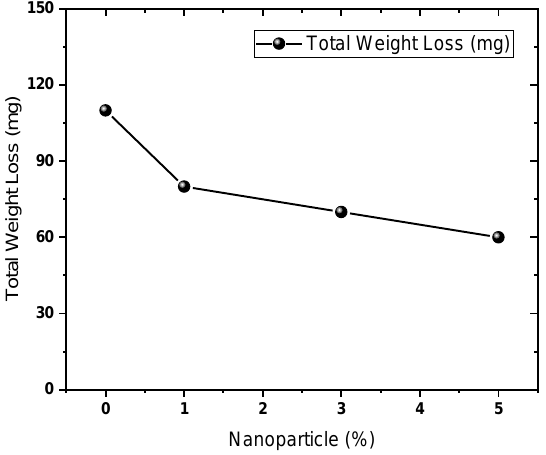
Figure 6. Weight loss for neat and modified epoxy coatings with different abrasion cycles.